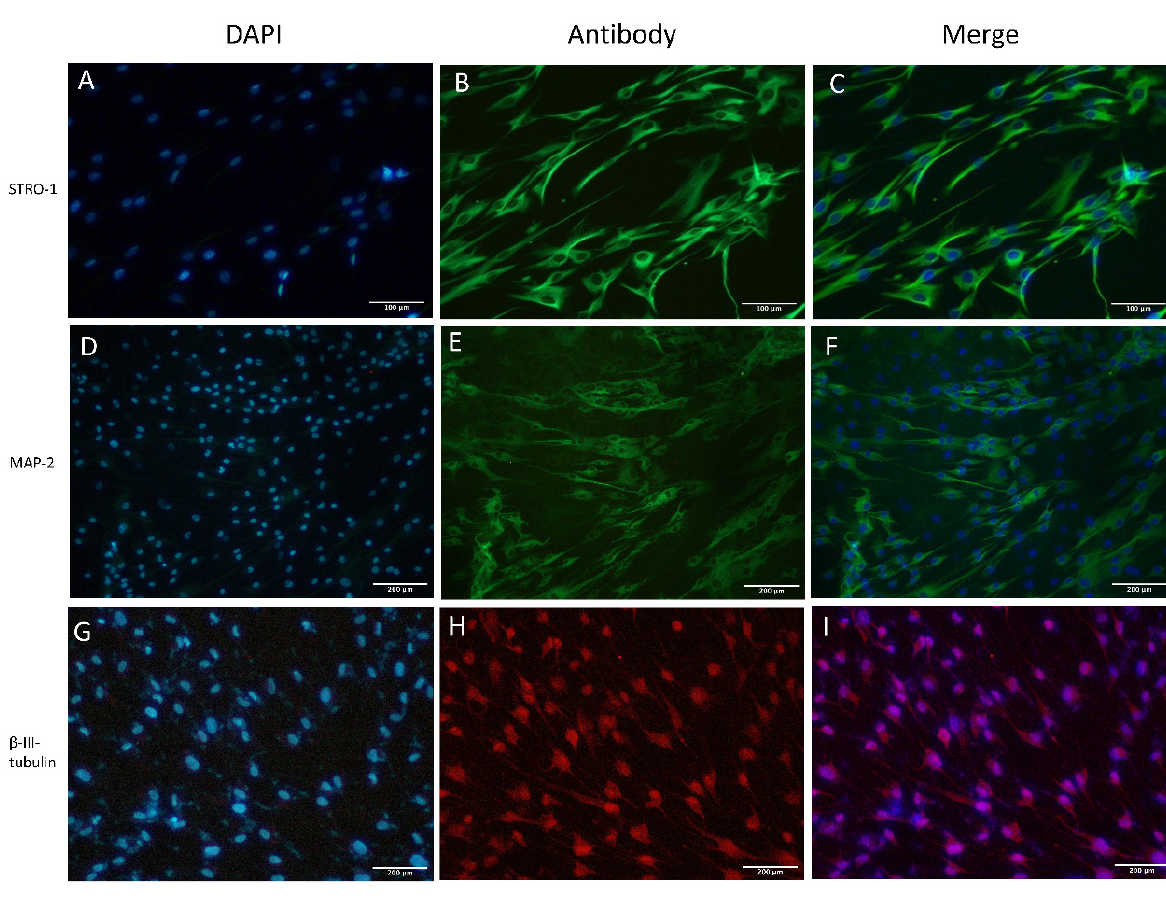
Fig. 3. Induced neural differentiation of passage 3 dental pulp stem cells in vitro. Nuclei of the cells were stained with DAPI (blue) shown in Fig. (A, D, G). STRO-1 was marked by immunofluorescence (green) shown in Fig. B. hDPSCs were stained with both DAPI and STRO-1. in Fig. C. Expression of MAP-2 stained in green shown in Fig. E. Expression of β-III-tubulin stained in red shown in Fig. H.